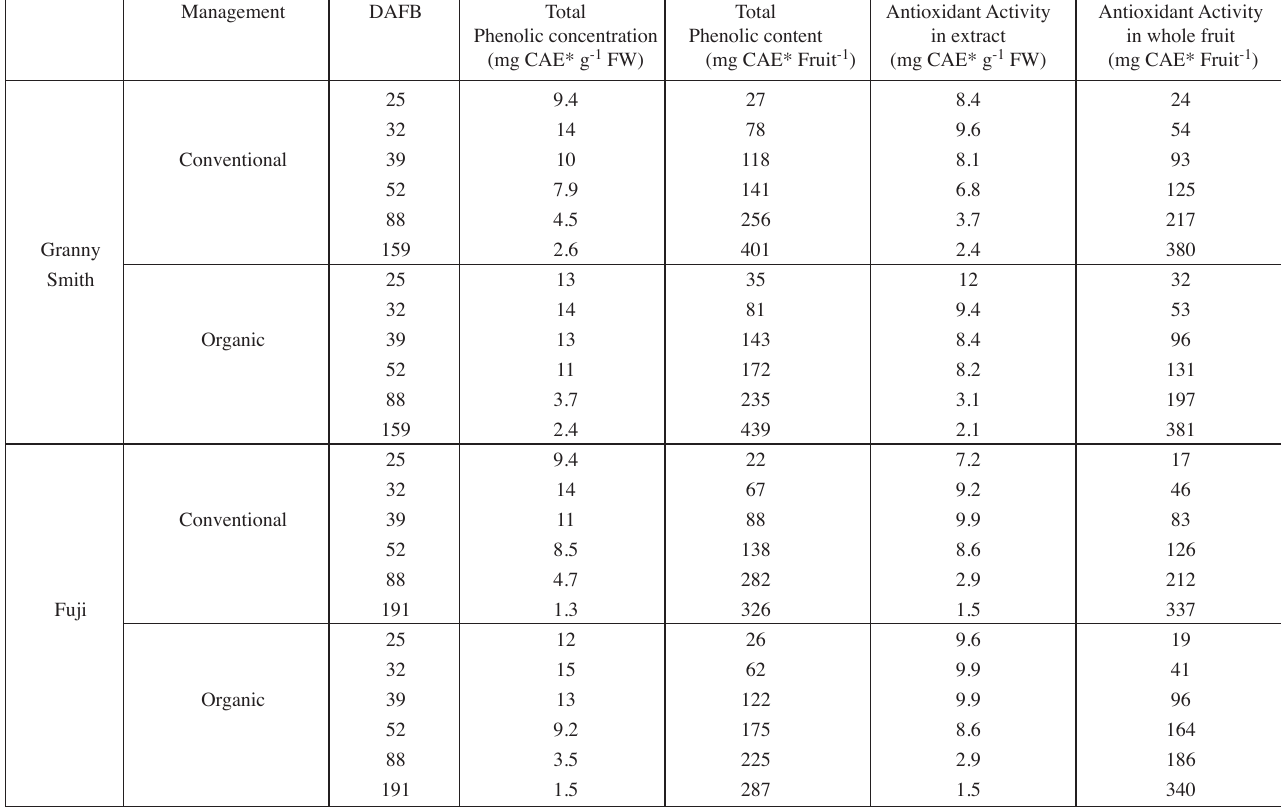
Tab. 6: Evolution of total phenolic concentration, total phenolic content, antioxidant activity in extracts and antioxidant activity in whole fruit from apples cvs. Granny Smith and Fuji , from conventional and organic orchards, in different stages of development, during the 2009/2010